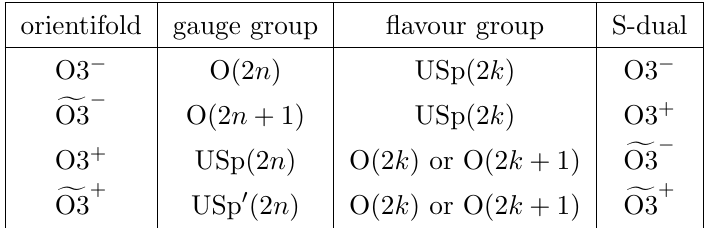
Table 3 . E(cid:11)ect of O3 orientifolds on the low-energy e(cid:11)ective theories. A stack of n full D3 branes and an O3 plane suspended between two NS5 branes gives rise to the electric gauge group. Moreover, + if there are 2 k half D5 branes, or in the case of O3 + and f O3 there may also be 2 k +1 half D5s, intersecting the D3-O3 stack then an electric (cid:13)avour group arises. Lastly, S-duality transforms the O3 planes among each other and the resulting magnetic gauge groups are the GNO duals [45] of the electric gauge